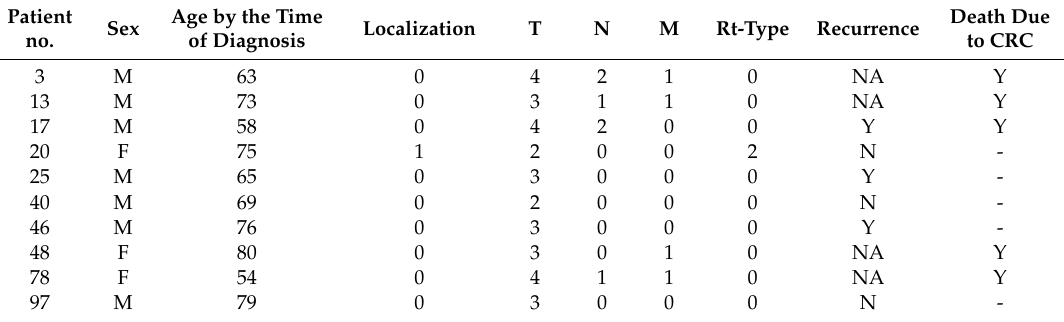
Table 1. Patient characteristics.